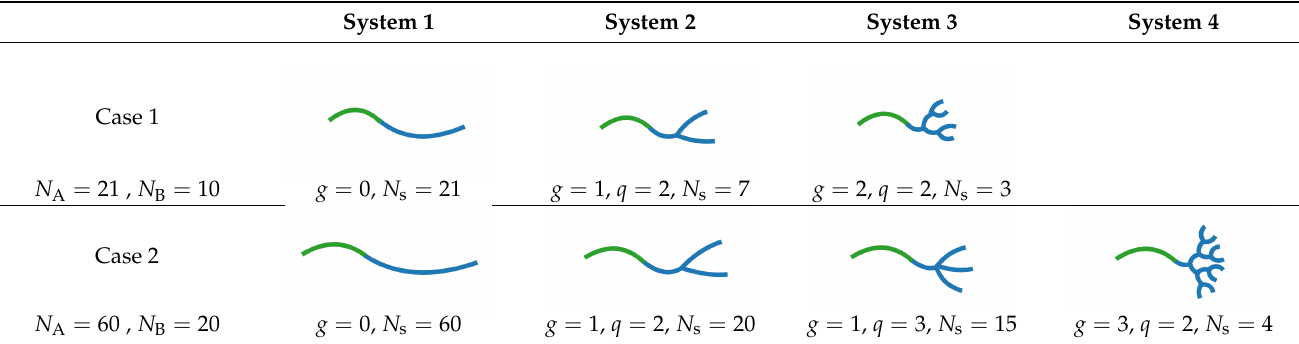
Table 1. Sketch representation of the simulated linear–dendritic block copolymers of case 1 and case